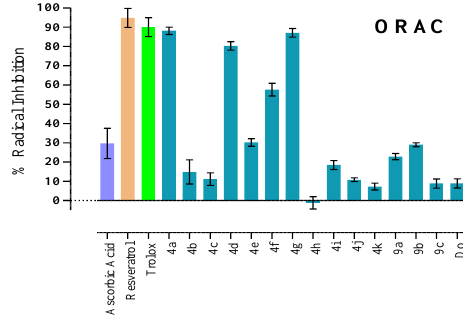
Figure 2. The percentage (%) of radical scavenging of three reference antioxidants (ascorbic acid, resveratrol, and trolox), hydrazones ( 4a – k ), isonipecotates ( 9a – c ), and donepezil ( Do ) determined in the oxygen radical absorbance capacity (ORAC) assay after 60 min. Data are expressed as means of the % radical scavenging ± standard deviation (SD), where the number of independent repeats is n = 3 [22].